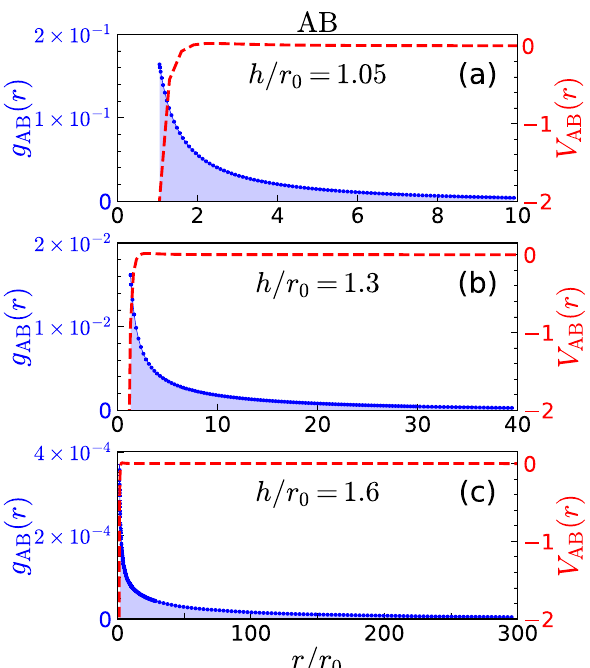
Figure 1. Interlayer pair distributions g A B ( r ) (left-axis, blue curves) and dipolar potentials V A B ( r ) (right- axis, red curves) for AB and for three values of the interlayer distance h / r 0 different scales in the r axis.